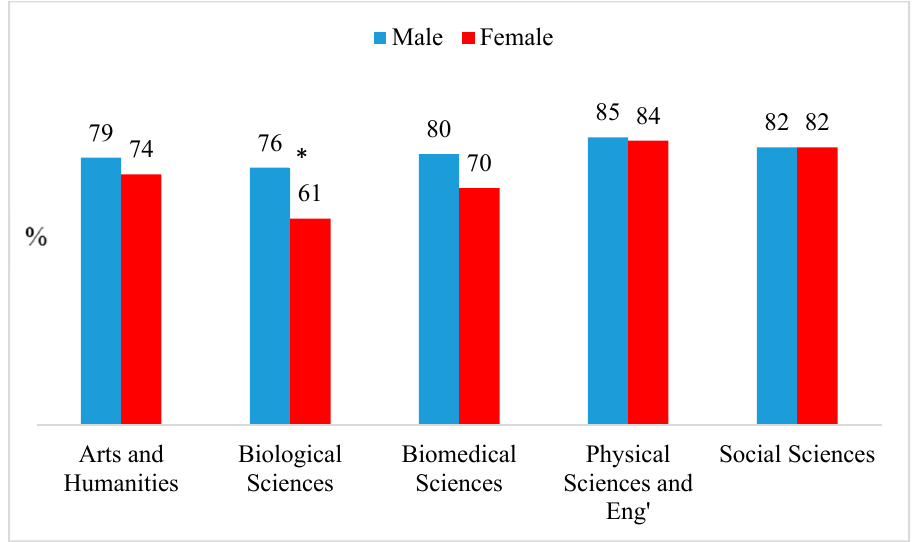
Figure 1. Proportion of doctoral graduates with a permanent job by gender and study discipline in 2013 (* p < 0.5).